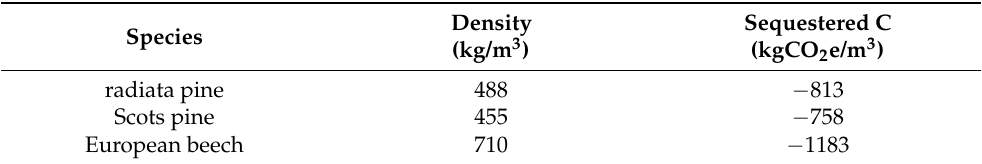
Table 7. Sequestered atmospheric carbon content of radiata pine, Scots pine and European beech, based upon typical densities and a moisture content of 10%.